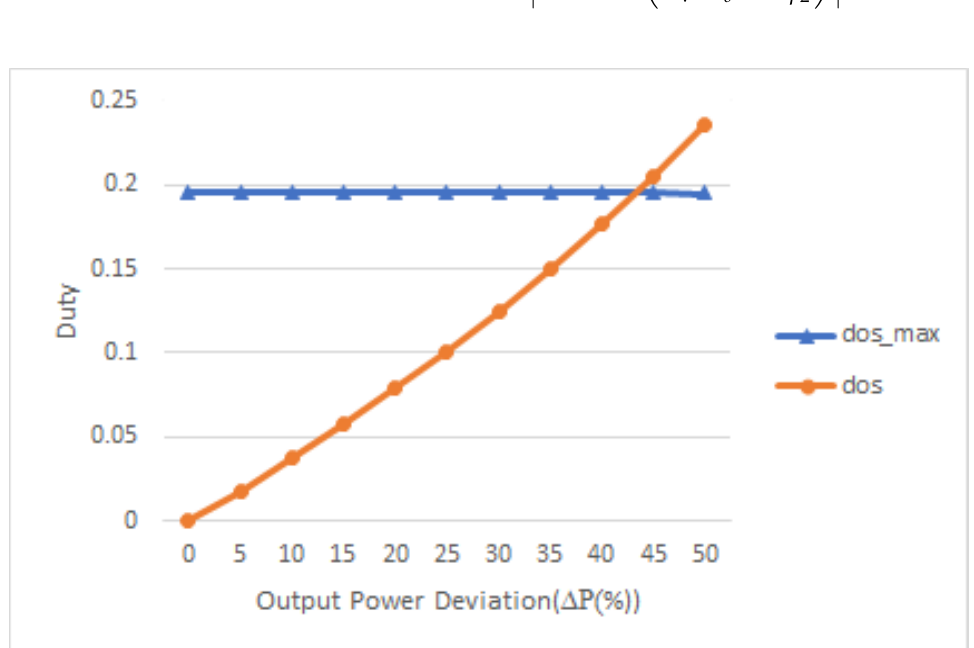
Figure 5. Maximum possible offset duty ( d os_max ) and required offset duty ( d os ) according to load variation under unbalanced condition.